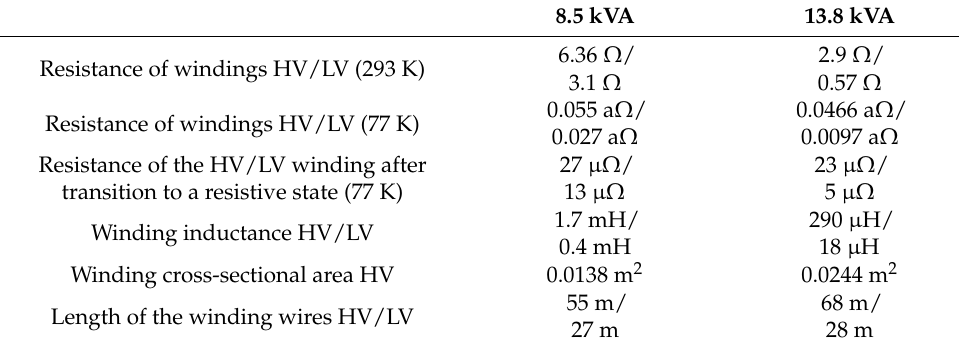
Table 2. Winding